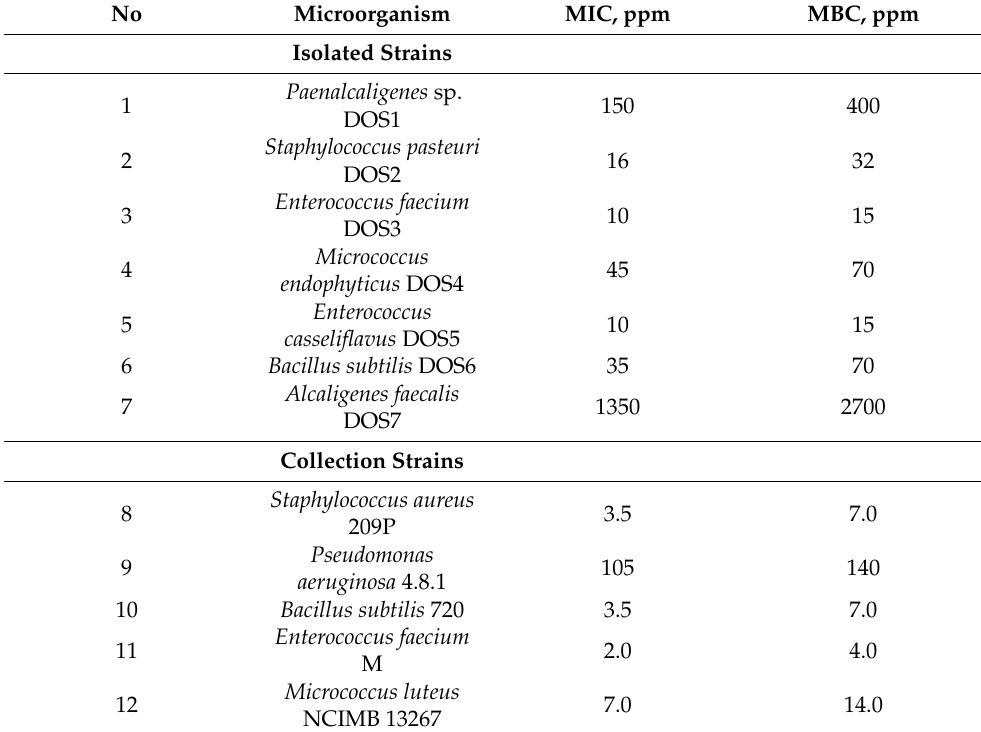
Table 2. MIC and MBC of sum of DDAC and PHMG (as part of “Latrina”) for isolated and some collection